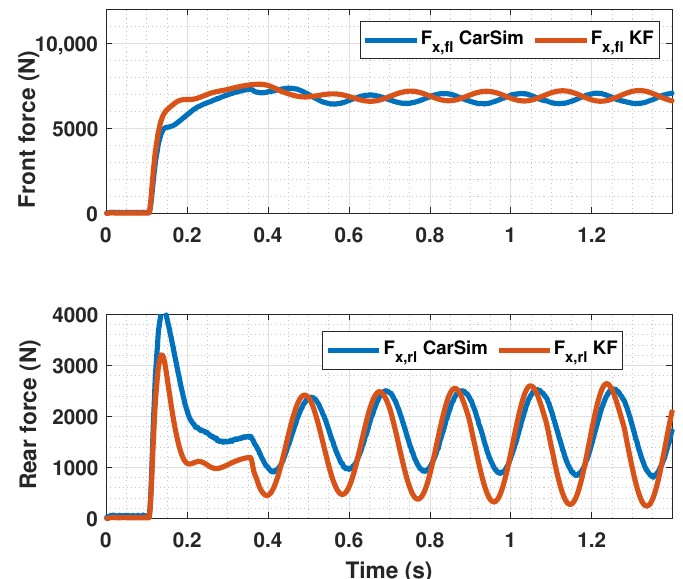
Figure 7. Estimated forces by KF compared with CarSim forces for µ max = 1.00.